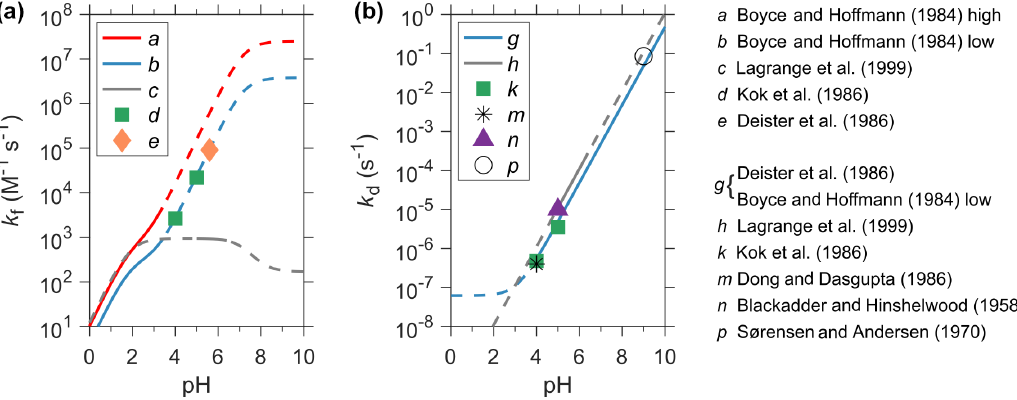
Figure 2. Comparison of rate constants for the formation (panel a , k f in M − 1 s − 1 ) and decomposition (panel b , k d in s − 1 ) of HMS from the available laboratory studies. Data are shown as a function of pH. Unless otherwise noted, rate constants are determined at or corrected to 25 ◦ C and under dilute conditions ( µ < 0 . 01M). For a , b , c , g , and h , the solid curves show the range of pH at which these experiments are performed, whereas the dash curves indicate the extrapolated values. Other experiments ( d , e , k , m , n , and p) are performed at discrete pH and shown by symbols. ( a ) the high k f is from Boyce and Hoffmann (1984) at µ = 1M. ( b) the low k f is also from Boyce and Hoffmann (cid:18) (cid:19) + 0 . 13 × x (1984) and corrected for µ and K h . ( c ) Lagrange et al. (1999): k f = K h × 0 . 73 × x M − 1 s − 1 . ( d ) Kok et al. (1986): HSO − 3 SO 2 − 3 the reported k f is limited by the dehydration rate of CH 2 ( OH ) 2 , k dh , and is thus corrected here. ( e ) is calculated using the k d and K eq determined by Deister et al. (1986) and is also corrected for k dh . The calculated k f values are 2 . 6 × 10 3 , 2 . 2 × 10 4 , and 9 . 1 × 10 4 M − 1 s − 1 , respectively, at pH = 4, 5, and 5.6 in ( d ) and ( e ). For comparison, the extrapolation of the low k f data ( b ) are 2 . 7 × 10 3 , 2 . 4 × 10 4 , and 9 . 3 × 10 4 M − 1 s − 1 , respectively, at pH = 4, 5, and 5.6. ( g ) k d is calculated using the K eq from Deister et al. (1986) and the low k f from Boyce and Hoffmann (1984). ( h ) Lagrange et al. (1999): k d = 1 . 1 × 10 4 × (cid:0) K w / (cid:2) H + (cid:3)(cid:1) at µ = 1M in the presence of H 2 O 2 . ( k ) Kok et al. (1986) measured k d of 4.8 × 10 − 7 and 3.5 × 10 − 6 s − 1 , respectively, at pH 4 and 5. ( m ) Dong and Dasgupta (1986) measured K eq at pH 4 and µ = 0.05 M, which translated to a k d of 4 × 10 − 7 s − 1 . ( n ) Blackadder and Hinshelwood (1958): k d = 1 × 10 − 5 s − 1 at pH 5 and µ ≈ 0 . 1M. ( p ) Sørensen and Andersen (1970): k d = 8 . 5 × 10 − 2 s − 1 at pH 9 and µ = 0 . 1M. For comparison, values of k d calculated by ( g) are 5.4 × 10 − 7 , 4.9 × 10 − 6 , and 4.8 × 10 − 2 s − 1 at pH 4, 5, and 9,